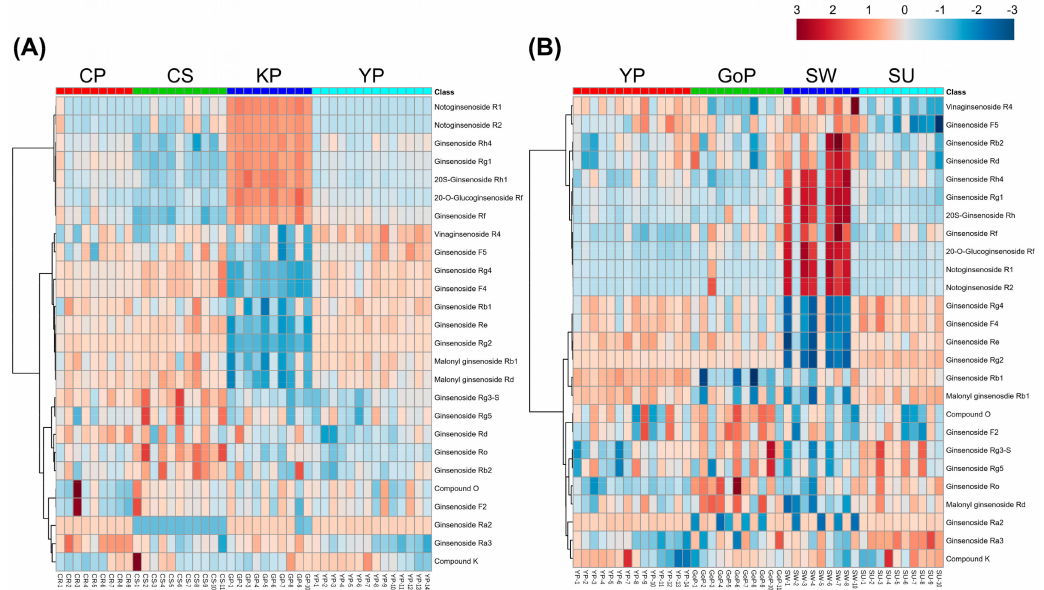
Figure 3. Heatmap of ginsenoside profiles from different cultivars. ( A ) Comparison of representative cultivars in each variant (CP, Chunpoong; CS, Chungsun; KP, Kumpoong; YP, Yunpoong). ( B ) Comparison of cultivars in the violet-stem variant (YP, Yunpoong; GoP, Gopoong; SW, Sunwon; SU,